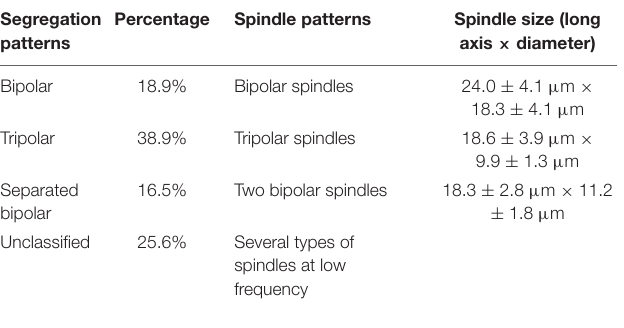
TABLE 1 | Spindle patterns and corresponding chromosome segregation patterns in meiosis II eggs from C. farreri following inhibition of PB1 with CB. Segregation